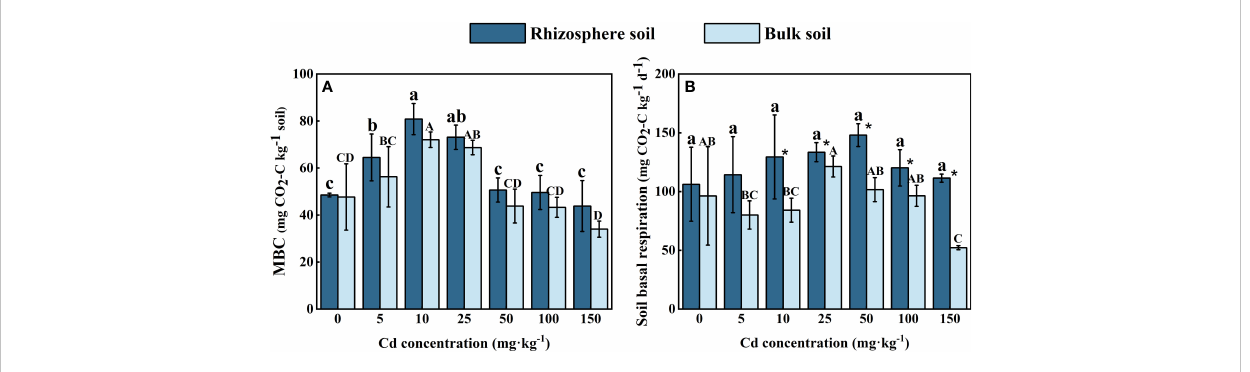
FIGURE 4 Effects of Cd on MBC (A) and soil basal respiration (B) in the rhizosphere soil and bulk soil of S. orientalis . Error bar represents standard deviation (n=3). * indicate signi fi cant difference at P < 0.05 level in the same treatment between rhizosphere and bulk soil, different lower case letter (upper case letter) at the column indicate signi fi cant difference at P < 0.05 level in the rhizosphere soil (in the bulk soil) according to ANOVA and Duncan tests, the same as